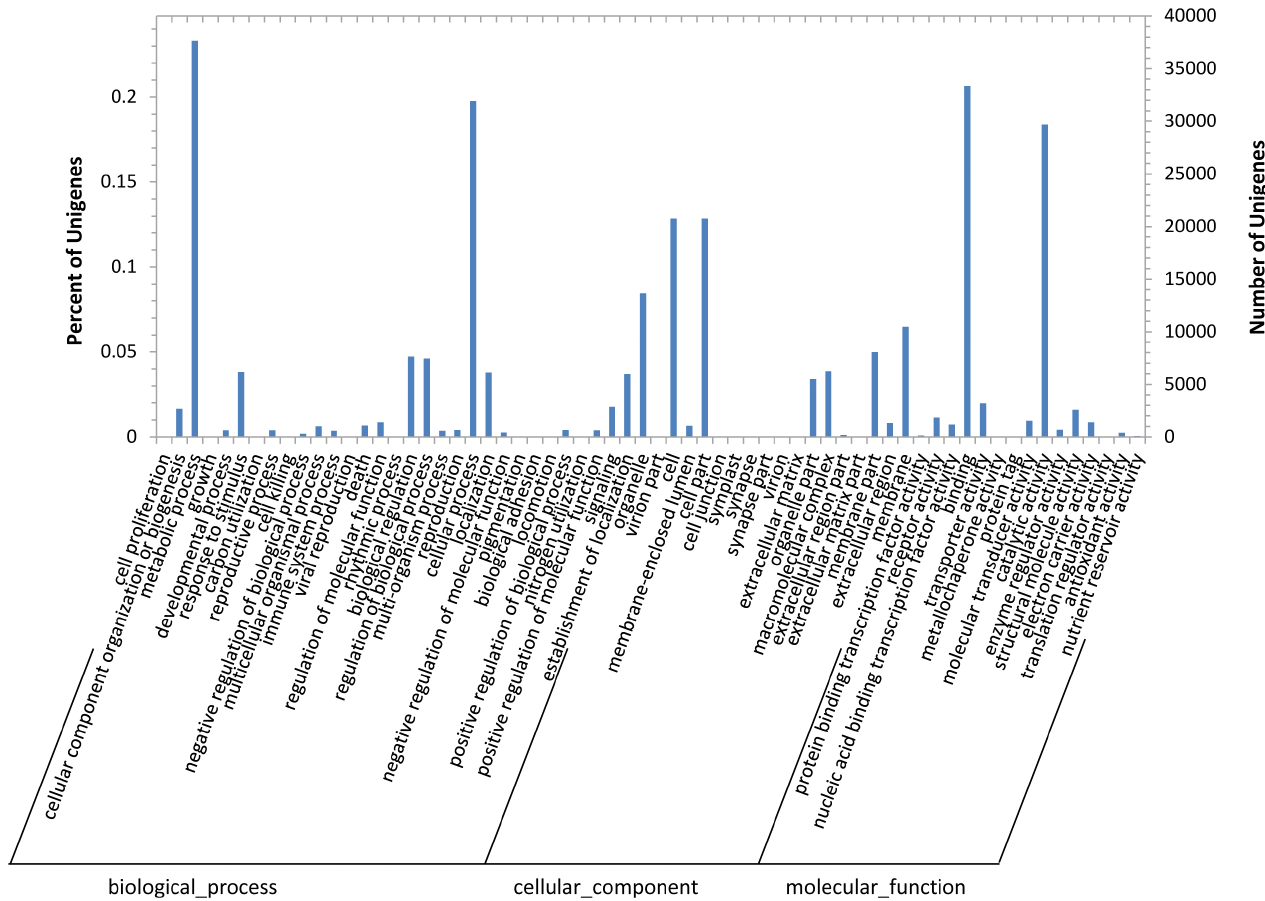
Fig 5. Chrysanthemum functional classification by gene ontology (GO) analysis. A total of 12,153 unigenes have been assigned GO terms and they are classified into three GO categories: biological process, cellular component, and molecular function.